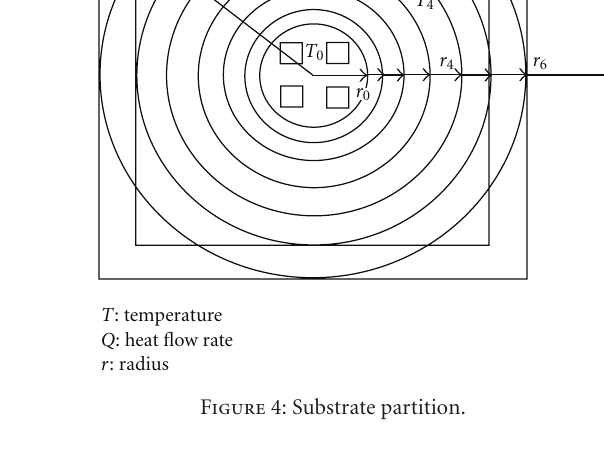
Figure 4: Substrate partition.